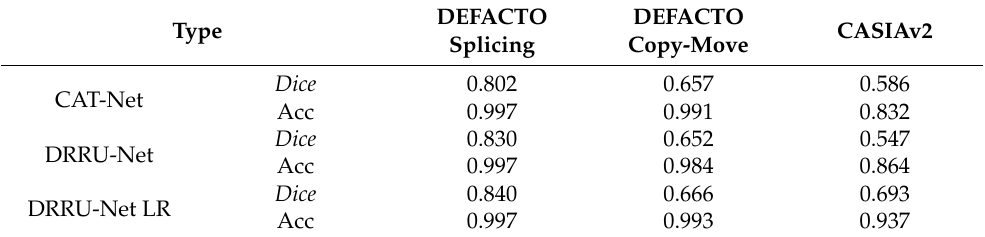
Table 3. Comparison among CAT-Net, DRRU-Net, and DRRU-Net LR without transfer